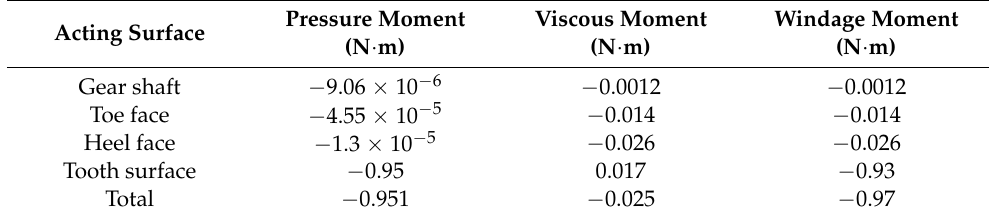
Table 2. Composition of total windage moment of